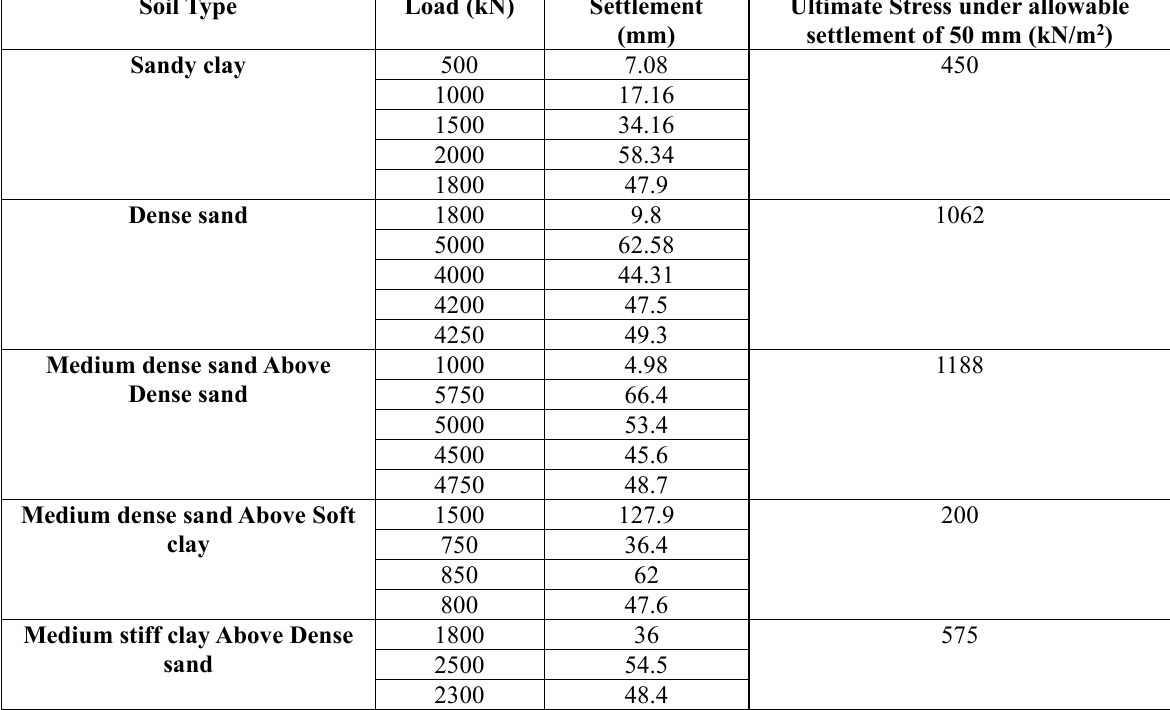
Ultimate Stress analysis of footing dimension (2 x 2) for different soil profile.